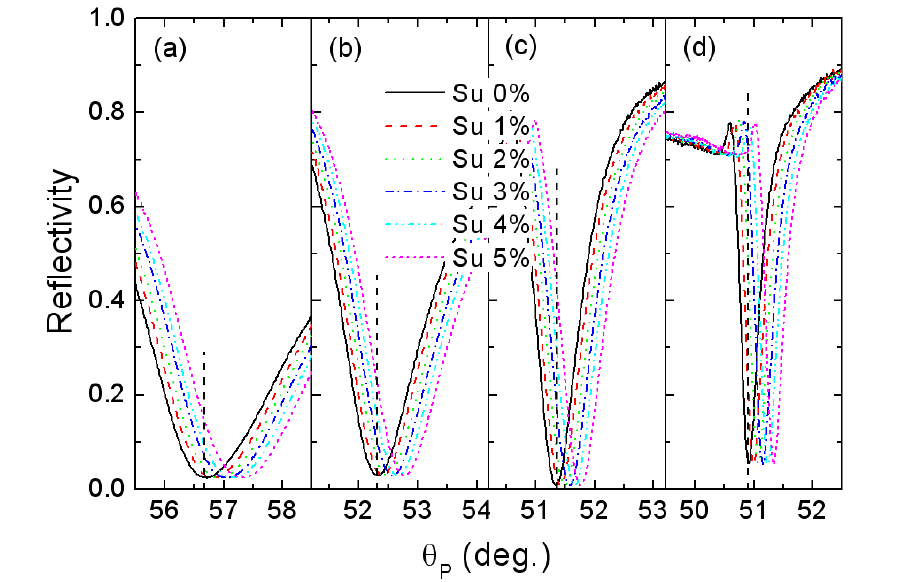
Figure 4. Measured SPR reflectivity curves with increasing the concentration of sucrose solution for each configuration shown in Figure 3, (a) the conventional SPR, (b) WCSPR, (c) Bi-WCSPR1, and (d) Bi-WCSPR2. The arrow lines indicate the position of reflectivity minima observed at pure